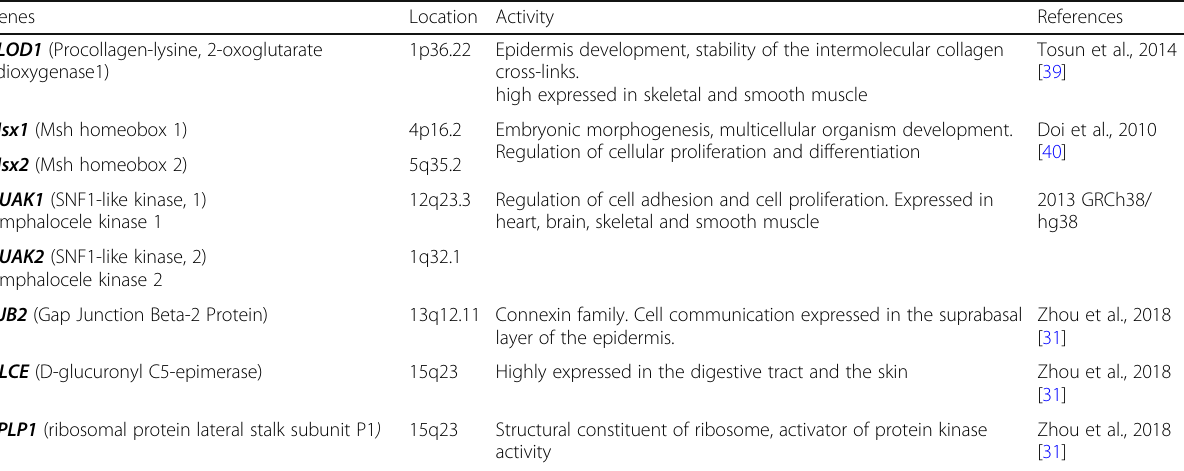
Table 2 Genes related to omphalocele (MalaCards 2019; 2013 GRCh38/hg38) Genes